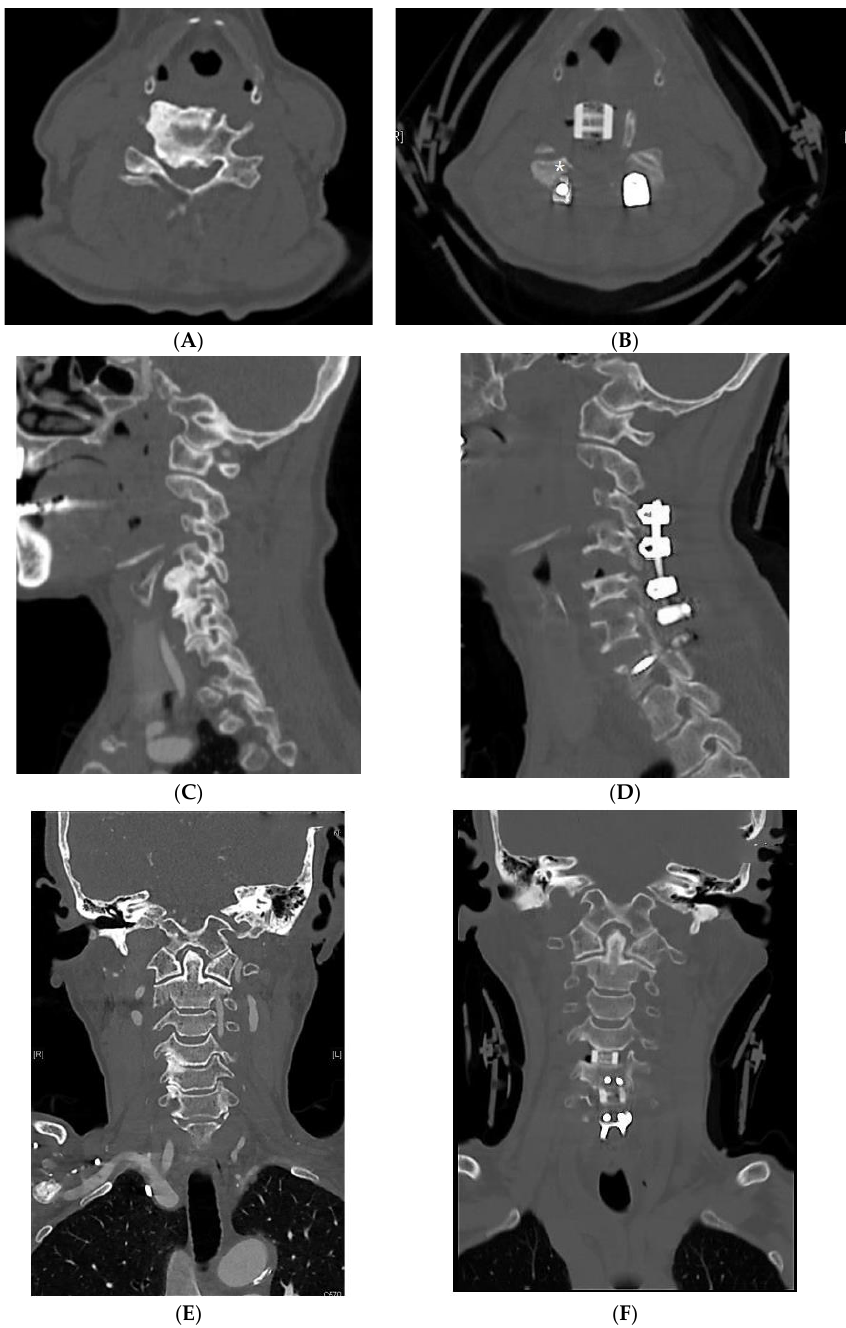
Figure 2. PAP LMS with uncovertebrectomy technique. ( A ) Preoperative CT axial image showing foraminal stenosis. ( B ) Postoperative axial image showing uncovertebrectomy with LMS and al- lospacer. Depending on the amount of dural shift, some risk of tethering of the C5 root still remains (marked with *). ( C ) Preoperative CT sagittal image showing severe C4–C5 foraminal stenosis. ( D ) Postoperative CT sagittal image showing the extent of foramen height, in addition to an uncover- tebrectomy in the presence of the allospacer and LMS. ( E ) Preoperative CT coronal image showing foraminal stenosis. ( F ) Postoperative CT coronal image showing uncovertebrectomy. CT, computed tomography; LMS, lateral mass screws; PAP, posterior